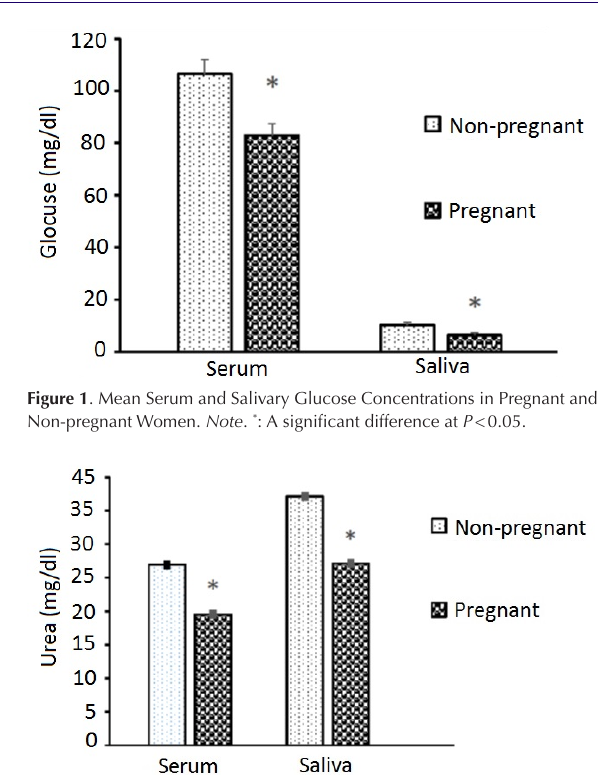
Table 1. Mean Saliva and Serum Glucose and Urea Levels in Pregnant and Non-pregnant Women